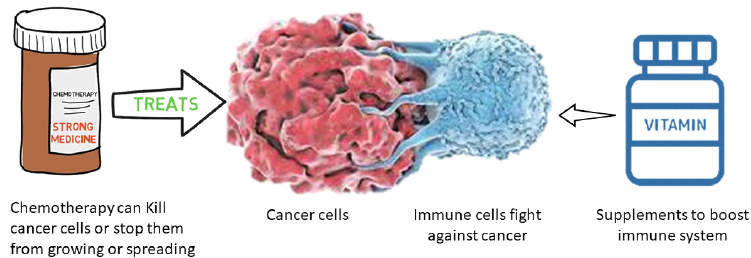
Figure 1. Schematic sketch of the CICV system.